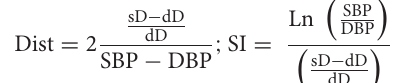
Frontiers in Physiology |